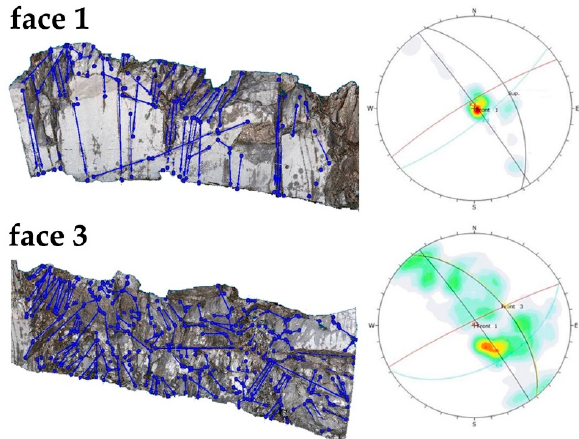
Figure 12. Traces identification (blue lines) on the portions of point cloud of the studied bench representing excavation faces 1 and 3 and obtained stereonets.